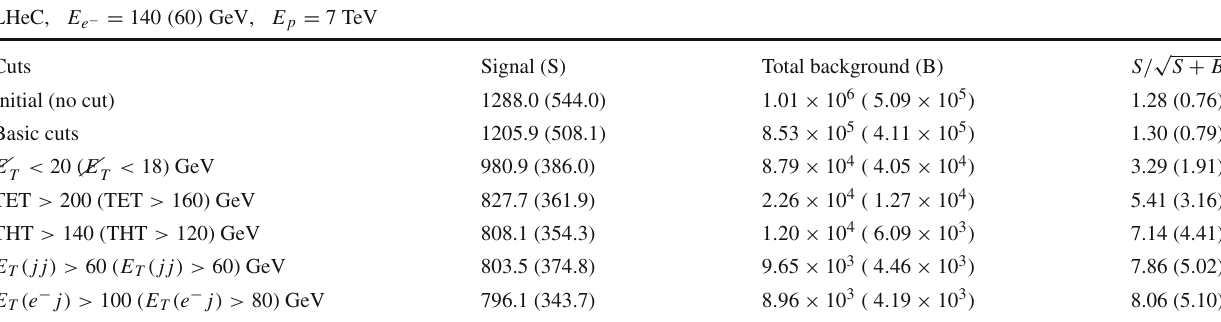
= 0 . 1 GeV and χ = 9 × 10 − 5 GeV − 1 and the SM backgrounds at the μτ